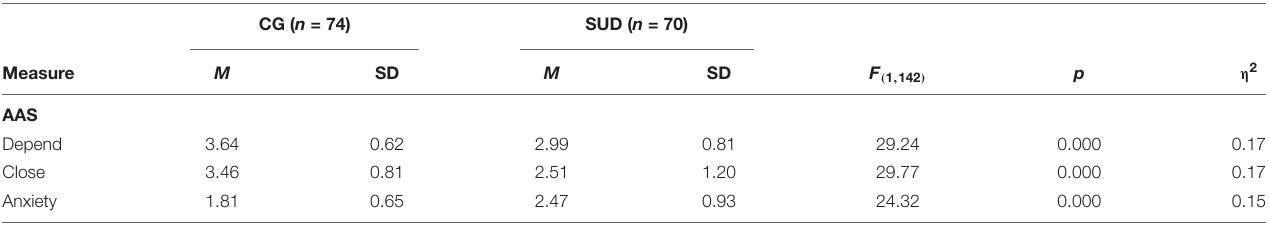
TABLE 3 | Group differences (ANOVA) in behavioral measures.